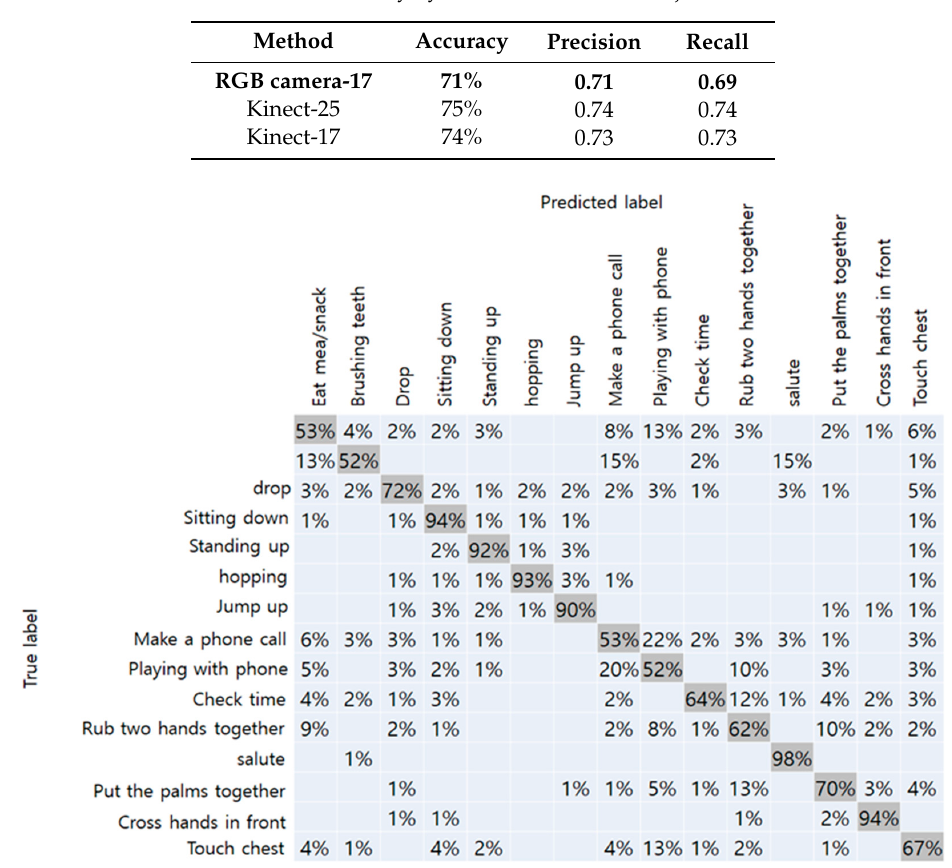
Table 2. Frames per second between models and module power modes.